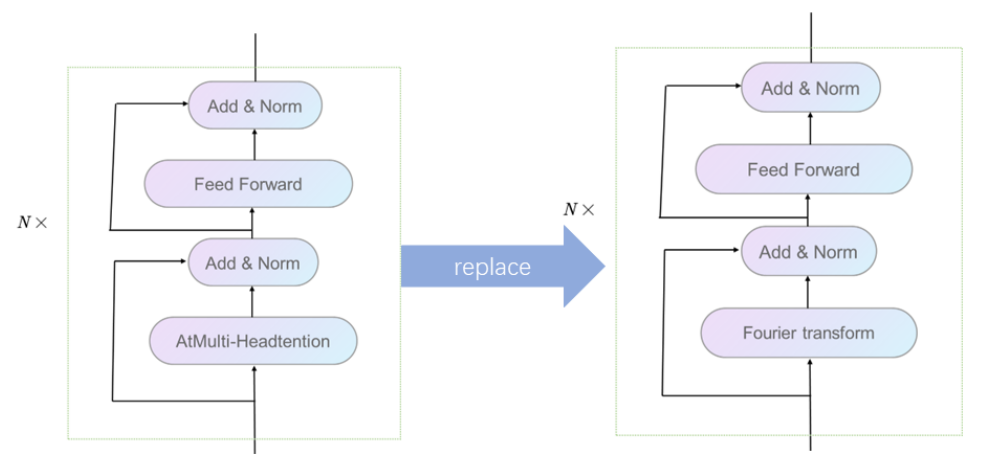
Figure 4. Linear transform replacement